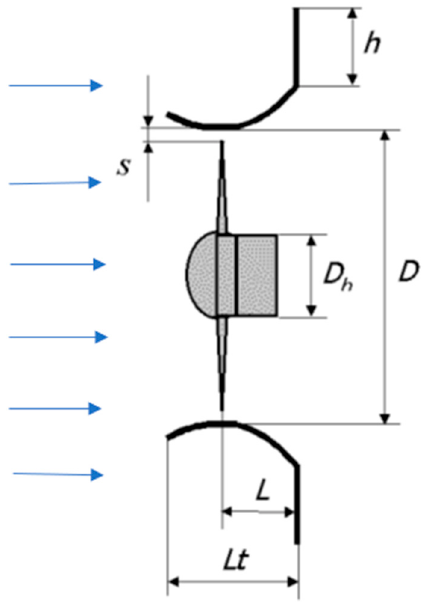
Figure 4. Diffuser-augmented HAWT with a brim (wind lens) 3 kW.